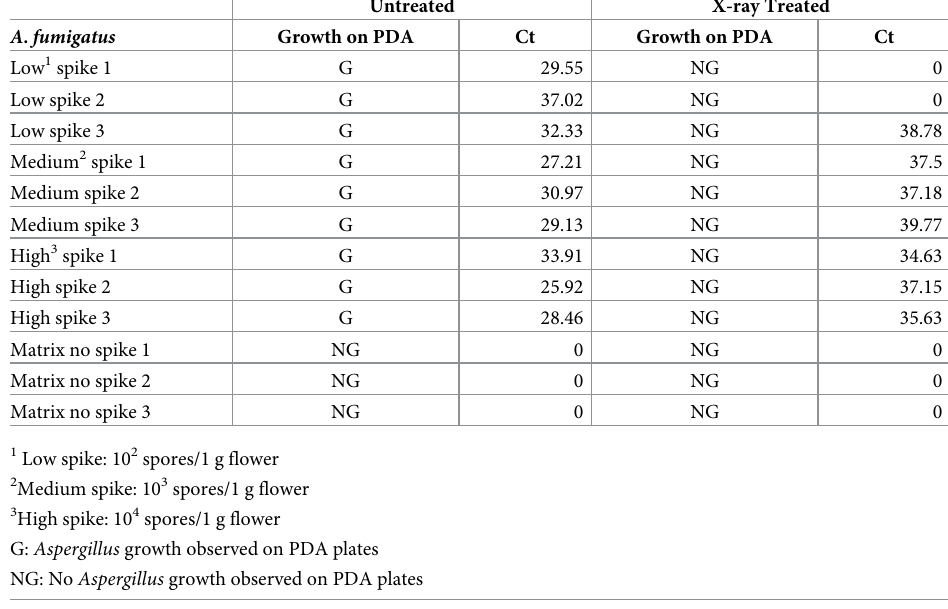
Table 4. PCR detection and viability of A . fumigatus at three spike levels, treated or untreated with 2.5 kGy of X- ray irradiation. Untreated X-ray Treated A . fumigatus Growth on PDA Ct Growth on PDA